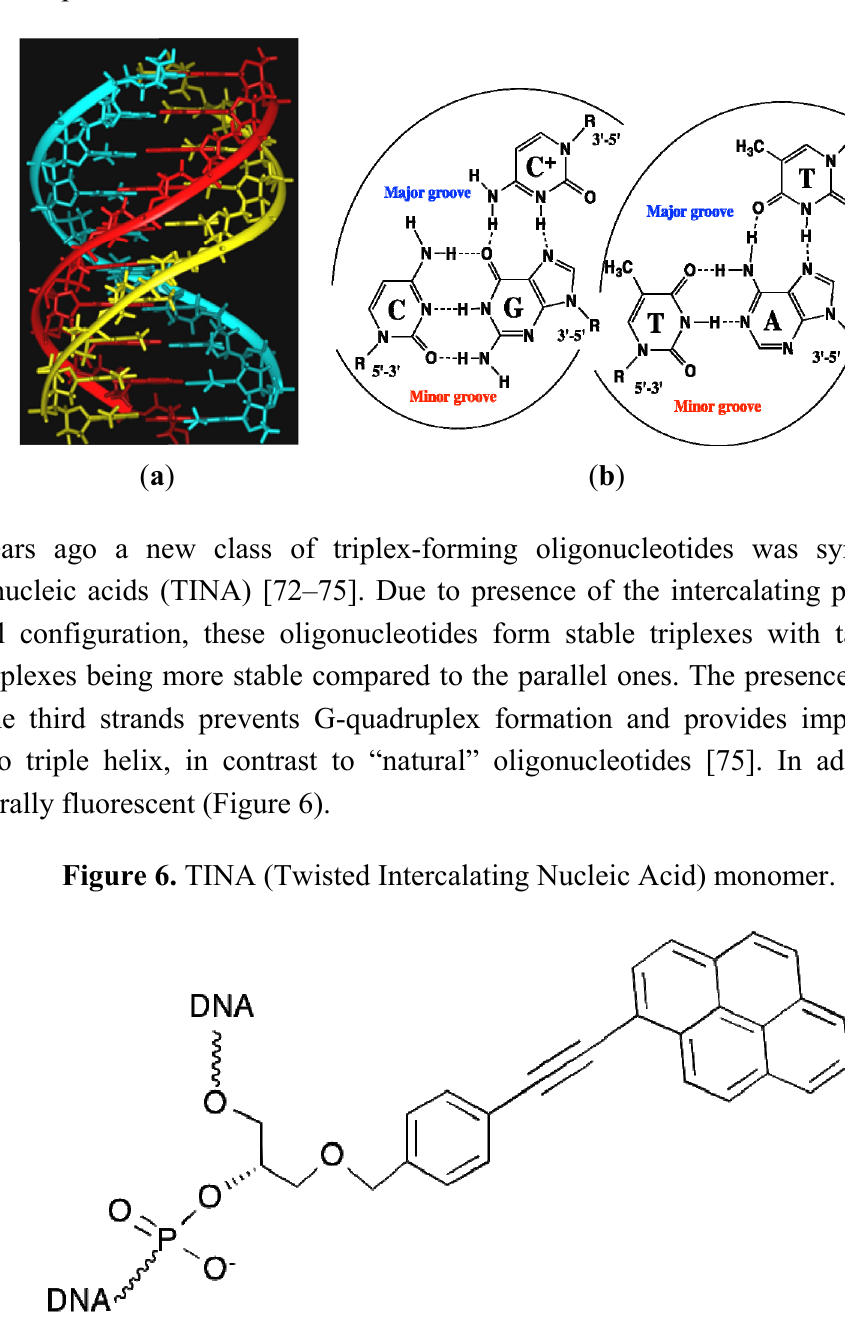
Figure 5. ( a ) DNA triple helix: polypurine strand (red), polypyrimidine strand (cyan) and third polypyrimidine strand (yellow) in a major groove of the duplex. ( b ) Examples of Hoogsteen triplets C:G-C and T:A-T.